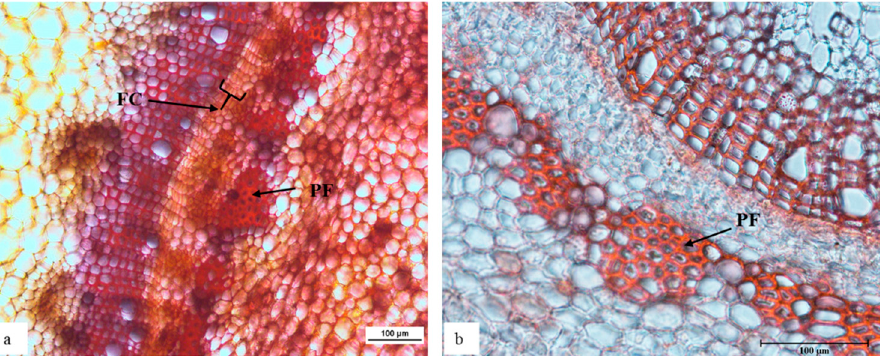
Figure 2. The shoot of rootstock ‘Velvick’ subjected to etiolation formed a thick and distinctive arrangement of cells as a continuous fascicular cambium ( a ), which was not identifiable after de-etiolation ( b ) of shoots. Transverse sections of ‘Velvick’ stem at 2.5 cm below the shoot tip: etiolated shoot ( a ), de-etiolated shoot ( b ). Stems were embedded in agar, sectioned at 50 µm, cleared with chloral hydrate and stained with Safranin O ( n = 5). FC = fascicular cambium and PF = phloem fibre.